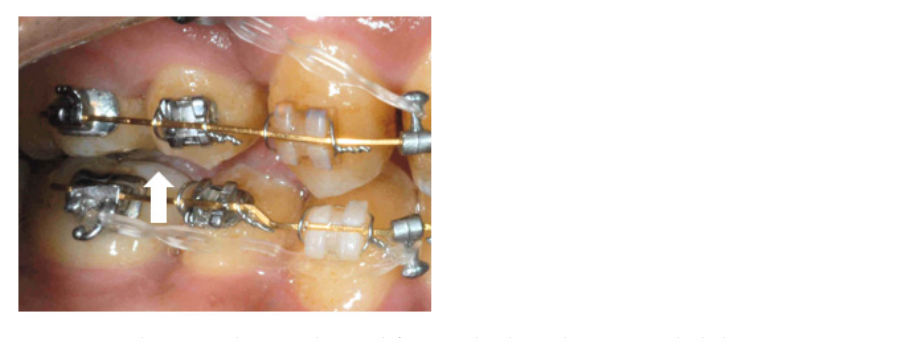
Figure 13. The second premolar and first molar have been intruded during retraction with TAD positioned at the apical region.